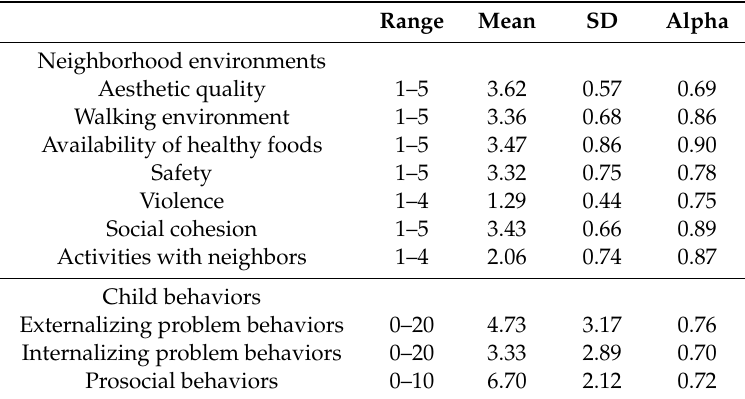
Table 1. Descriptive statistics of all study